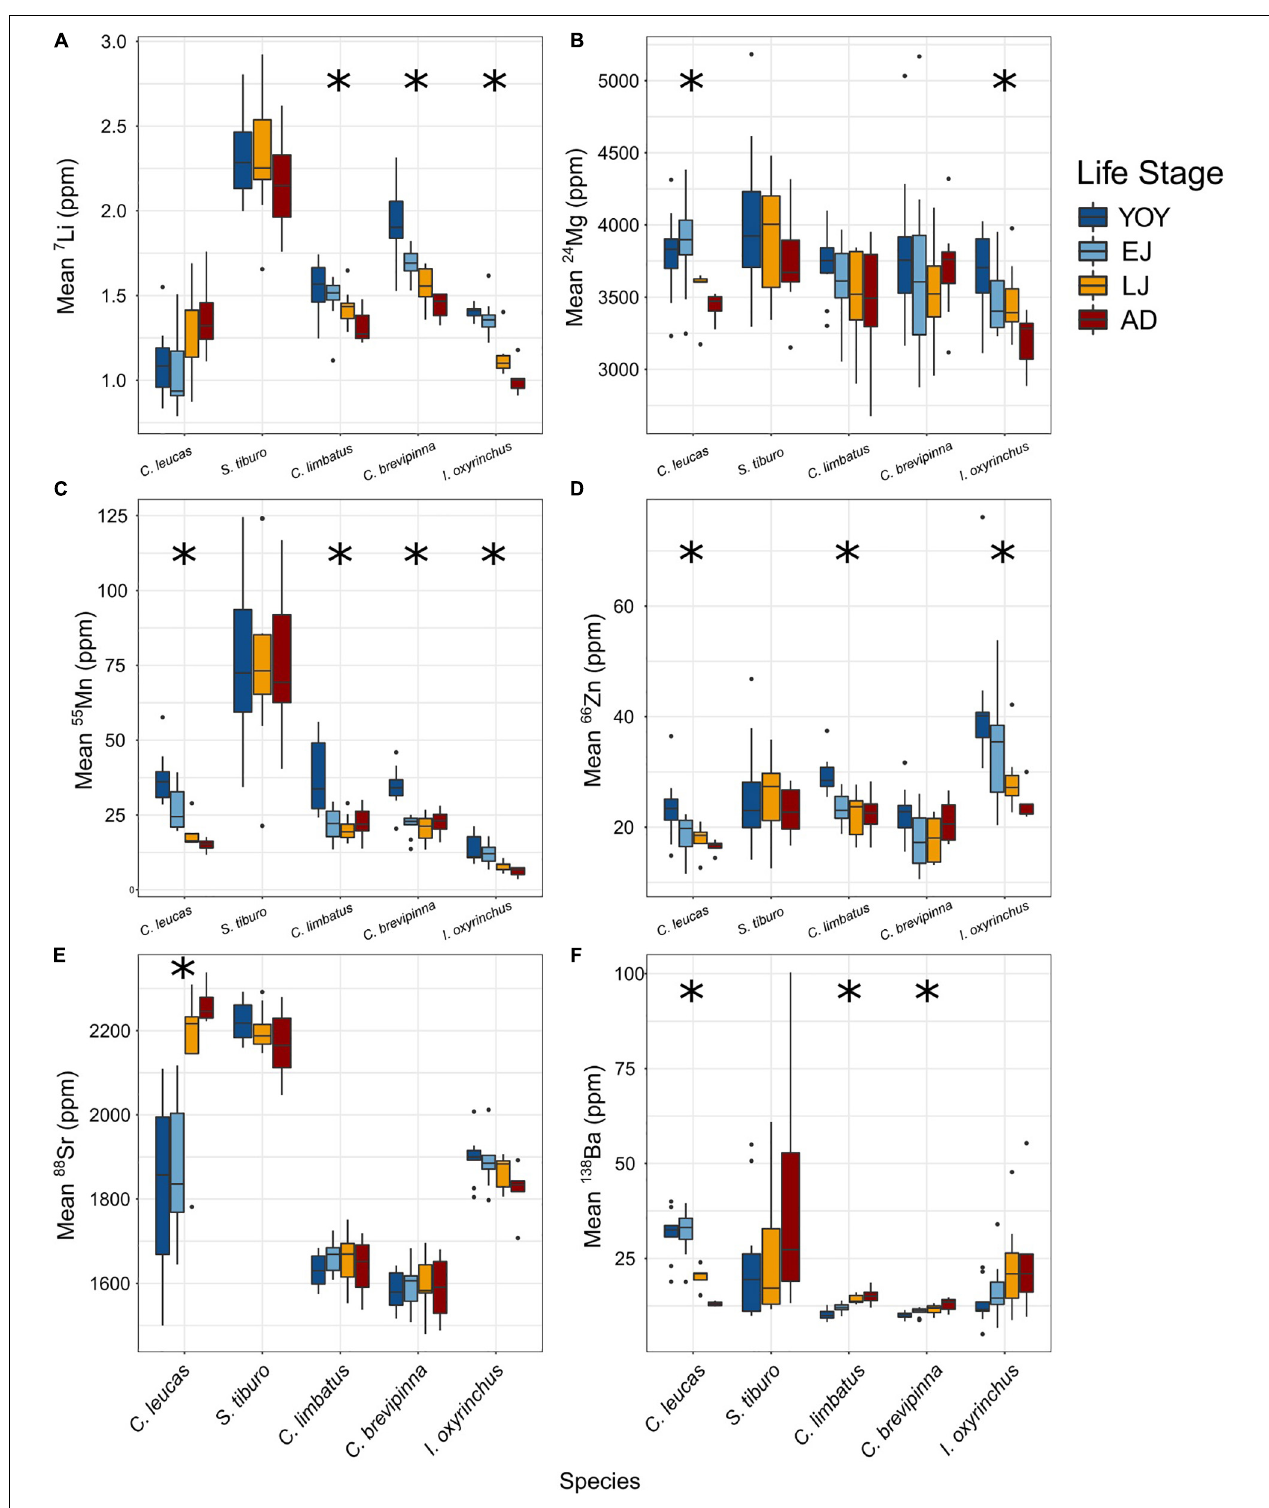
FIGURE 5 | Boxplots visualizing differences among life stages for each element and species, with life stage represented by color. Boxes show the 25th percentile, median, and 75th percentile, with whiskers representing 1.5 times the interquartile range. Outliers (data points that fall outside the range of the whiskers) are represented by black circles. Asterisks represent species with statistically significant differences among life stages (ANOVA). The asterisks (*) indicate statistical significance.